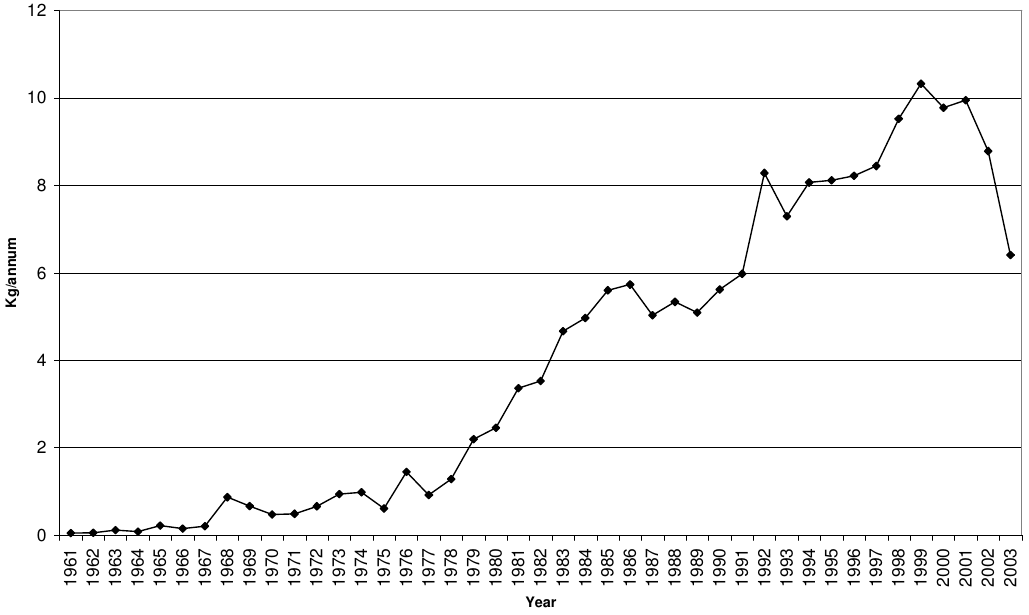
Figure 5: Rape oil availability in the UK, 1961-2003 (Source: FAOSTAT data,